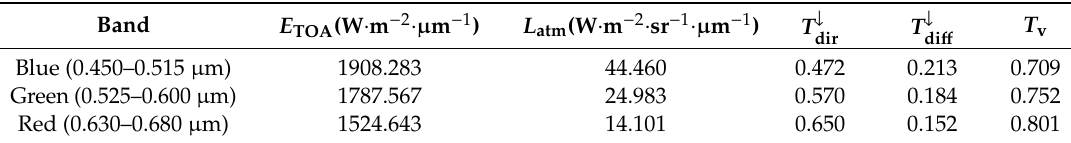
Table 1. The simulation results of solar radiative and atmospheric parameters obtaining from the 6S model.